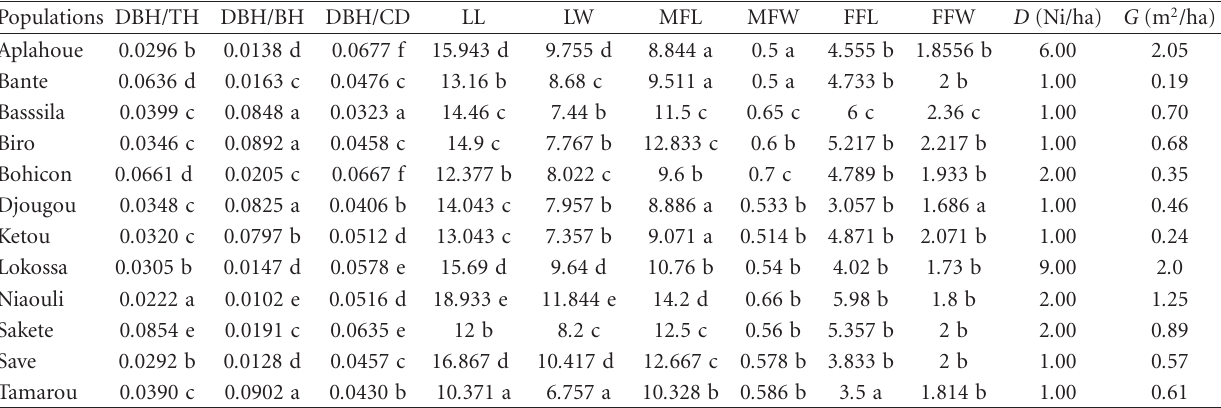
Table 4: Morphological variation of the twelve studied Milicia excelsa populations.